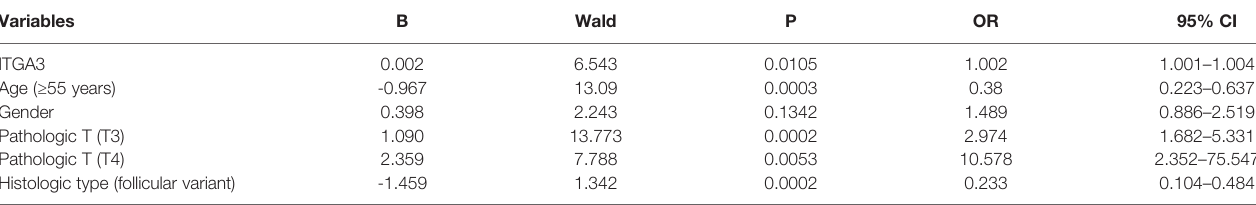
Pathologic T (T4)